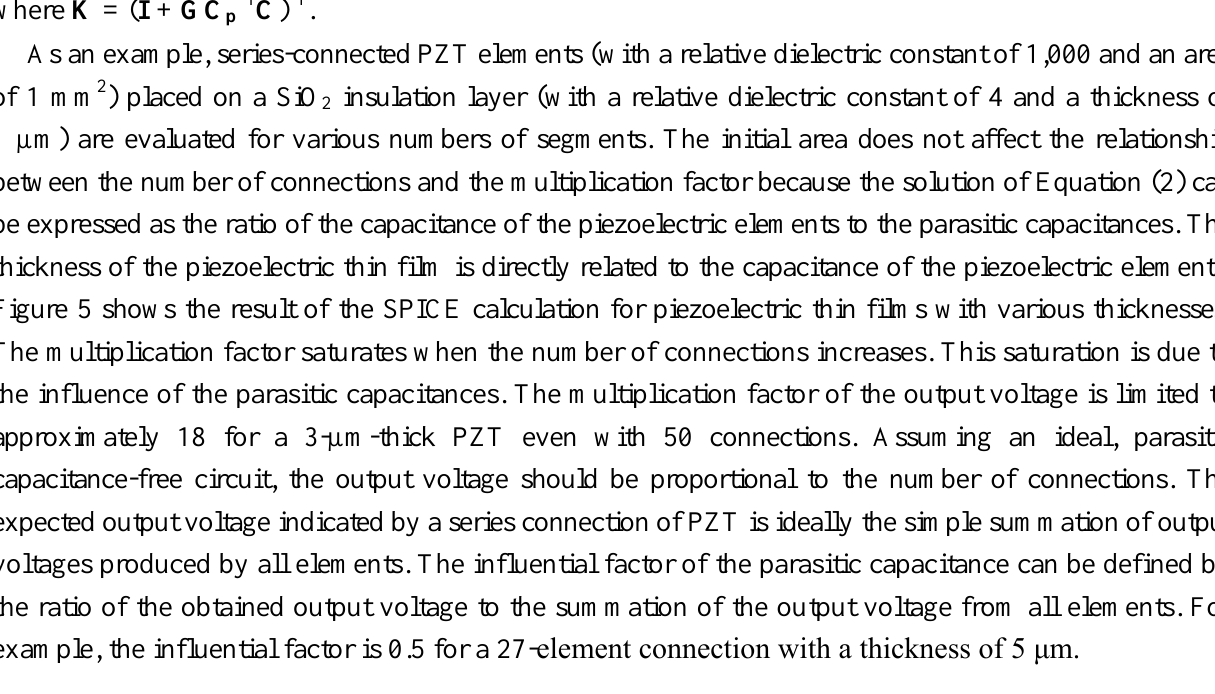
Figure 5. Calculated results using SPICE for series-connected PZT